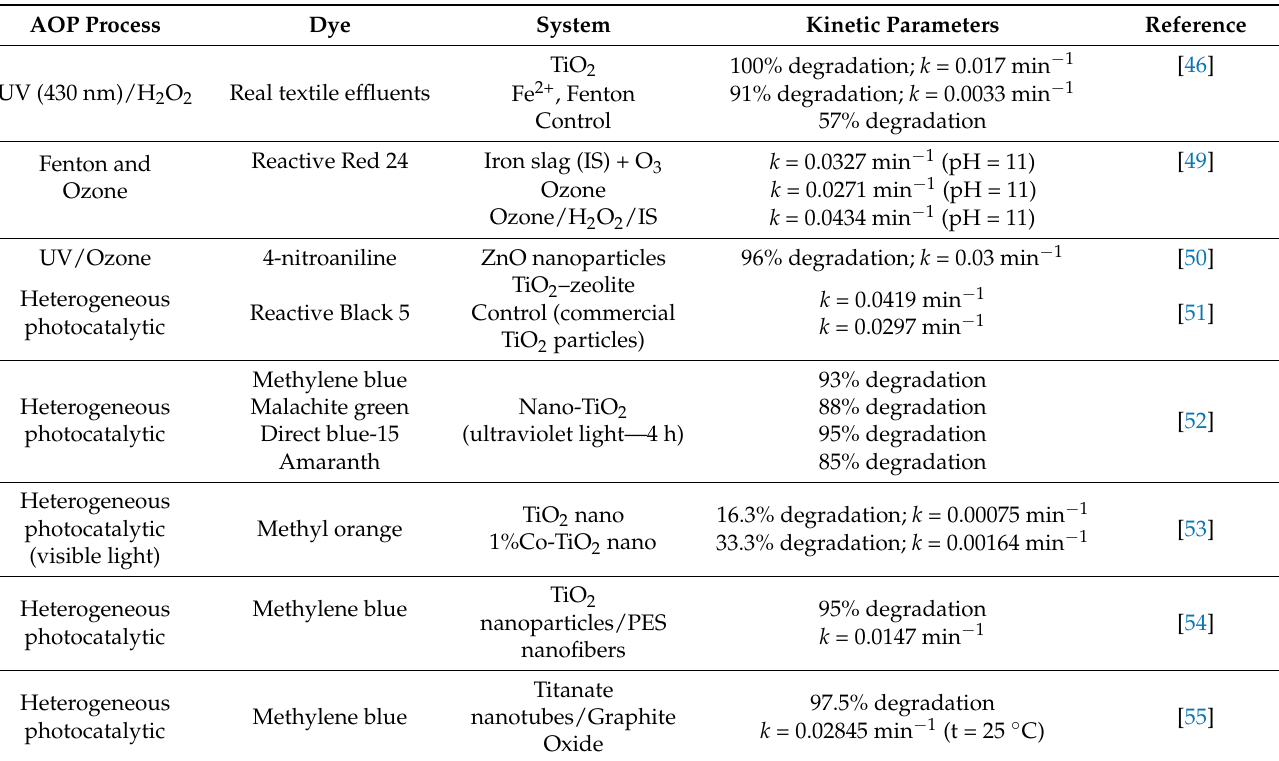
Table 1. Some examples of nanomaterials based AOP for the treatment of waste water containing dyes. AOP Process